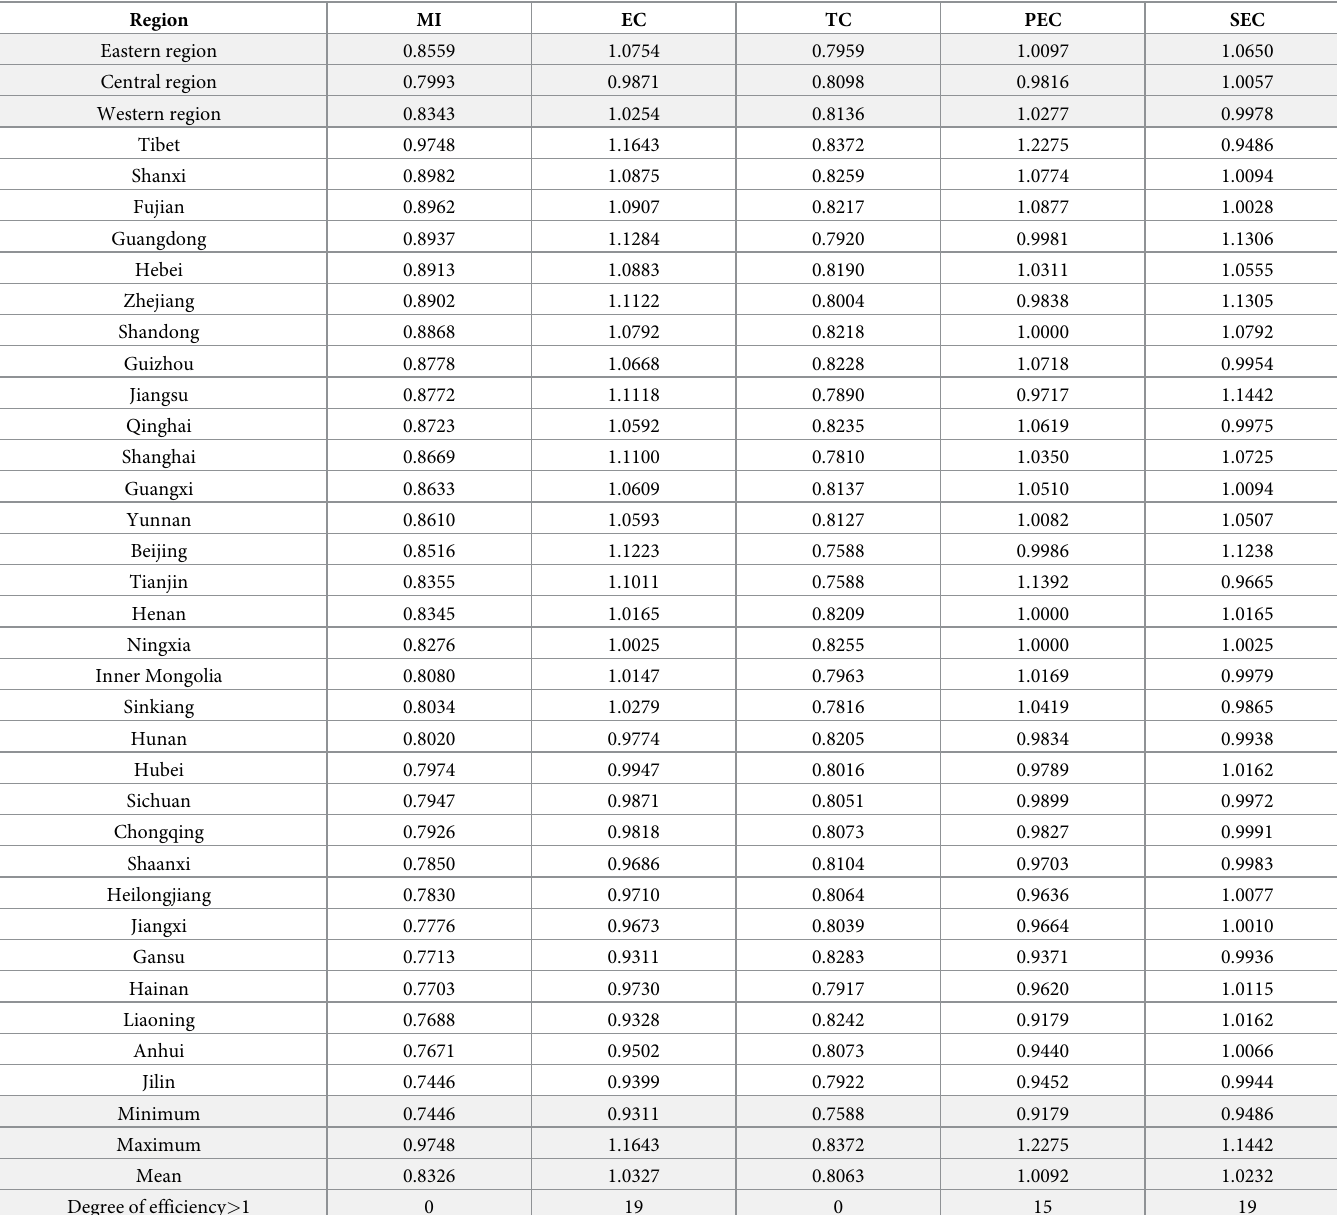
Table 2. Total factor productivity effectivity of the 31 provinces in China before the new healthcare reform